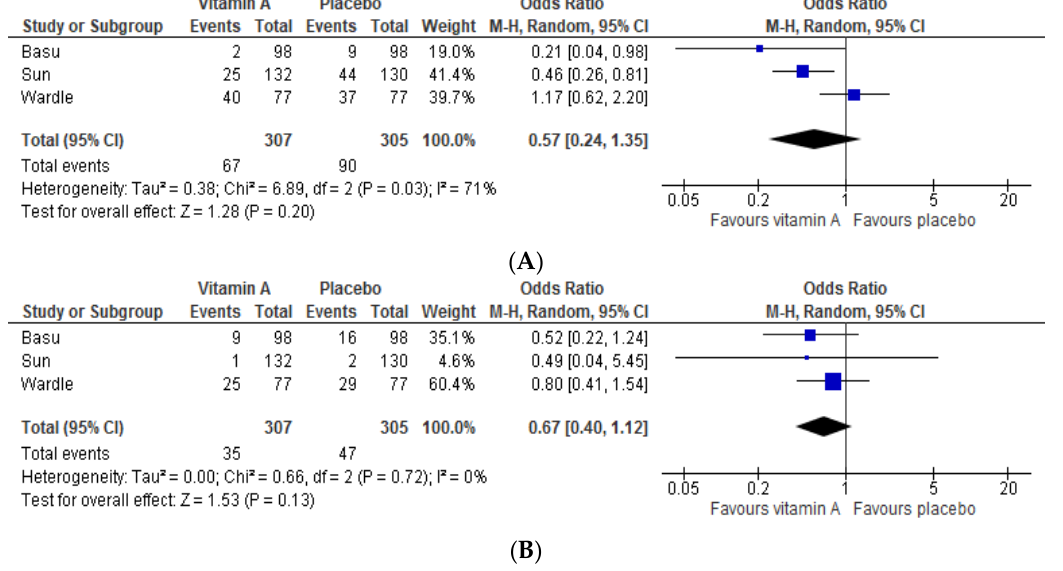
Figure 3. Effect of any enteral vitamin A supplement on BPD ( A ) and mortality ( B ). Figure 3. E ff ect of any enteral vitamin A supplement on BPD ( A ) and mortality ( B ). BPD: bronchopulmonary